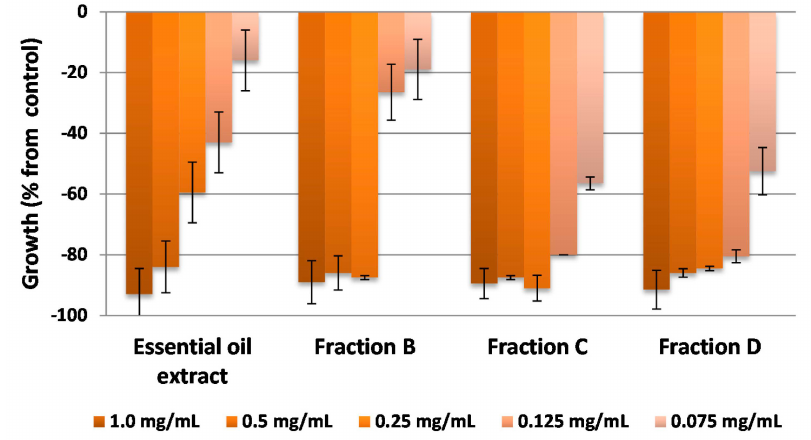
Figure 3. Bioactivities obtained in the etiolated wheat coleoptile bioassay for the essential oils extract and the fractions obtained by chromatography from citrus waste from Citrus sinensis. Values are expressed as percentage difference from